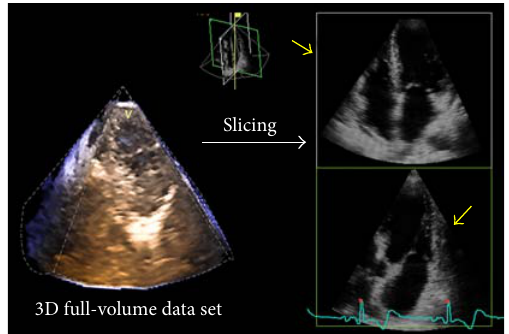
Figure 6: The 3D data set can be sliced in several 2D cut planes to obtain multiple views of that particular chamber (in the figure a 4–chamber view, upper panel, and an orthogonal view of the left ventricle and the left atrium, lower panel). Simultaneous visualiza- tion of orthogonal 2D slices enables the assessment and comparison of wall motion at every segment level of the ventricle, precious for assessing severity and extension of hypertrophy or regional wall motion evaluation both at rest and during